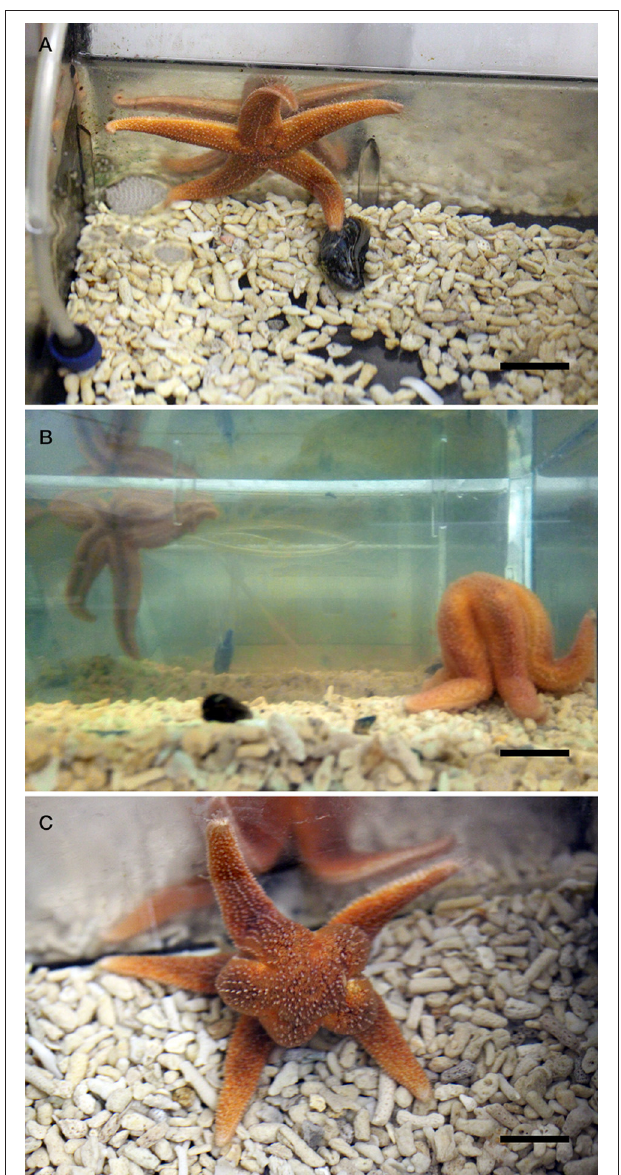
FIGURE 1 | Feeding behavior of the starfish A. rubens in a laboratory setting. (A) Here a specimen of A. rubens can be seen making contact with a mussel ( M. edulis ) in an aquarium tank. In experiments reported in this paper, the time elapsed from when the starfish was placed at the opposite end of the tank to the mussel to when the starfish made contact with the mussel (“time to touch”) was measured and recorded. (B,C) Here a specimen of A. rubens can be seen enclosing a mussel at the onset of a feeding bout, with photographs taken from a side view (B) and from above (C) . In experiments reported in this paper, the time elapsed from when the starfish was placed at the opposite end of the tank to the mussel to when the starfish enclosed the mussel (“time to enclose”) was measured and recorded. Scale bars: (A) : 2cm; (B) : 2.5cm; (C) : 1.5cm.